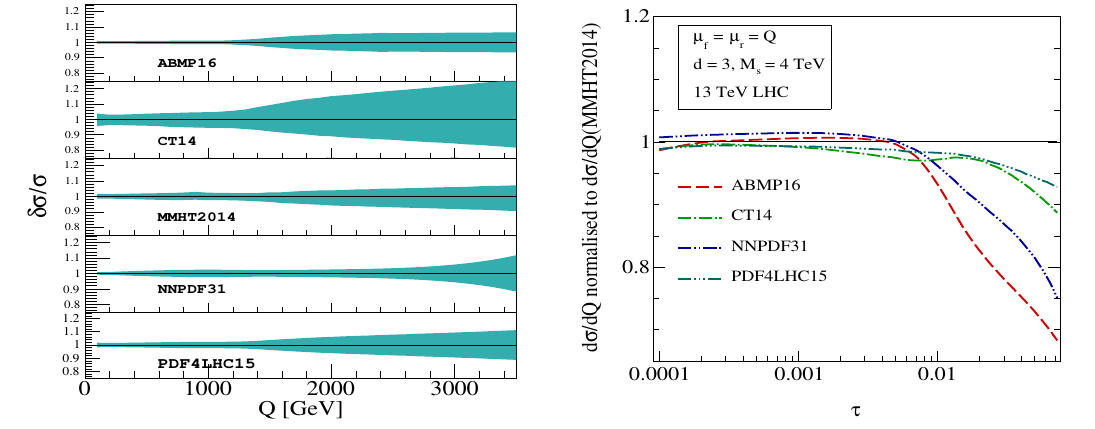
Figure 6 . PDF uncertainties for di(cid:11)erent PDFs (left panel) at NNLO and the result for di(cid:11)erent PDFs (right panel) normalized by the result obtained with the default choice MMHT2014nnlo at